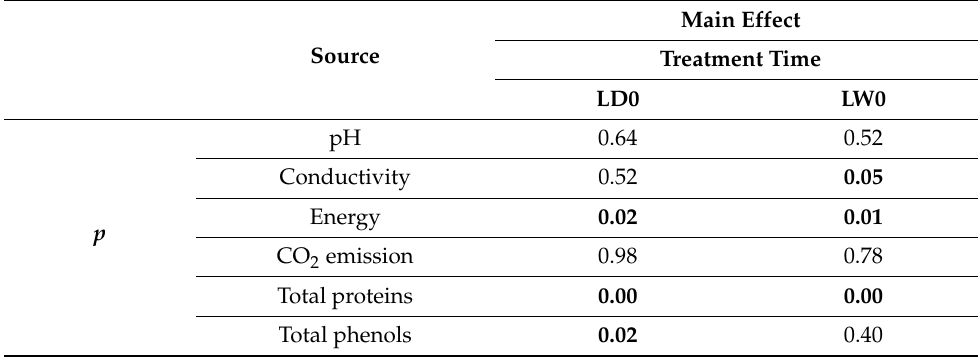
Table 8. Statistical significance for pH, conductivity, energy, CO 2 emission, total proteins, and total phenols. ANOVA table presents the influence of treatment time on the output variables of LD0 and LW0